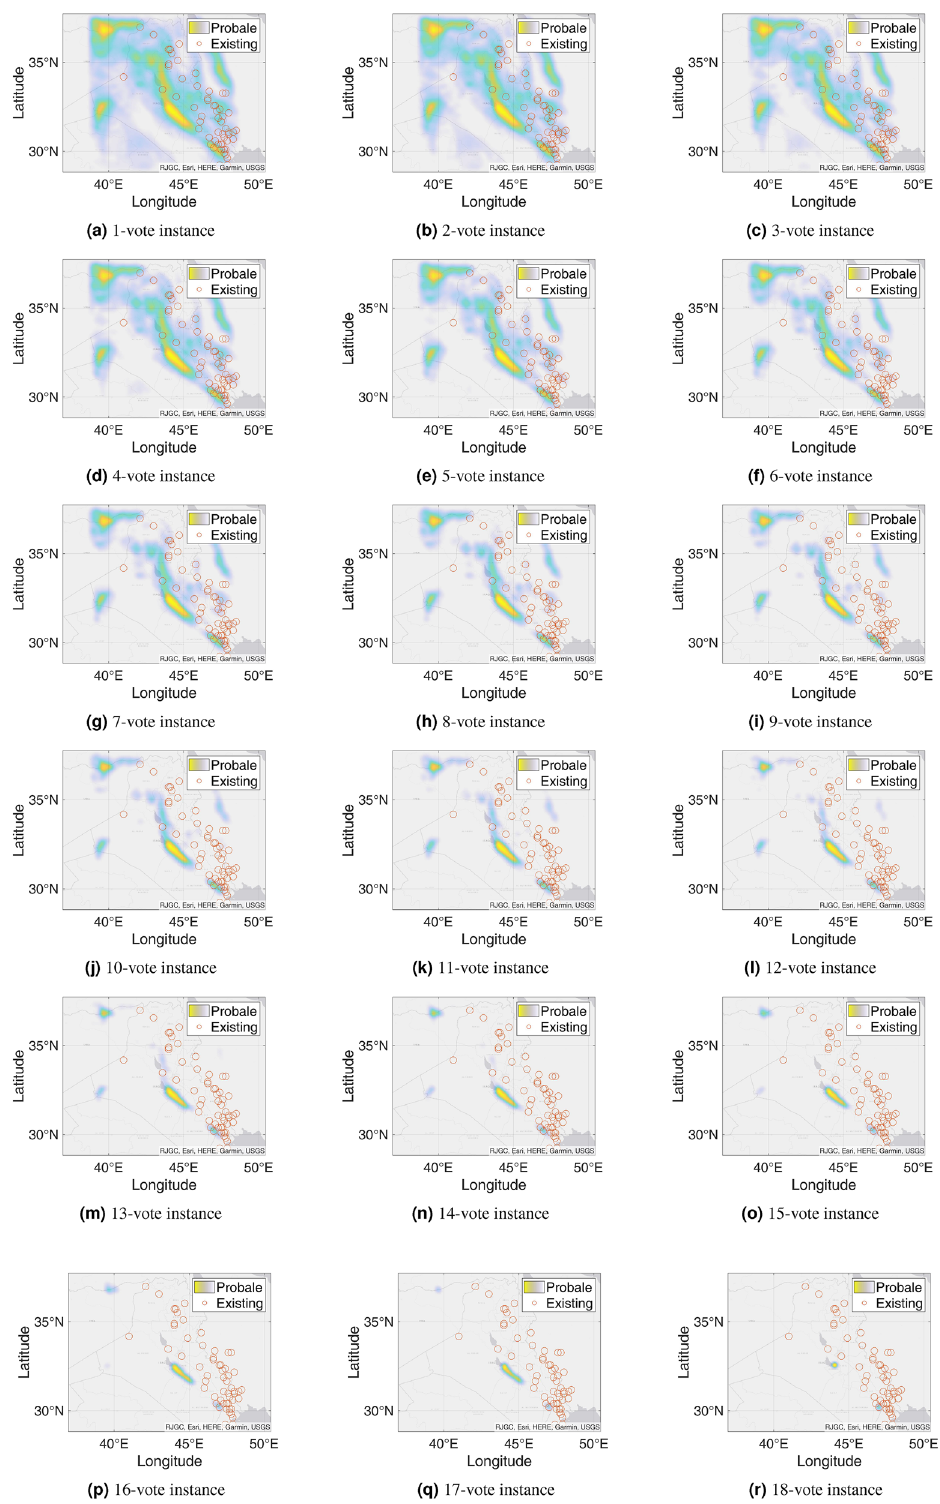
Figure 15. Probable petroleum deposits based on the frequency of 1 to 18 votes over our 22 best-performing models from the matrix-based analysis over the new test dataset from Harvard (the figures are created using MATLAB 2021a 51